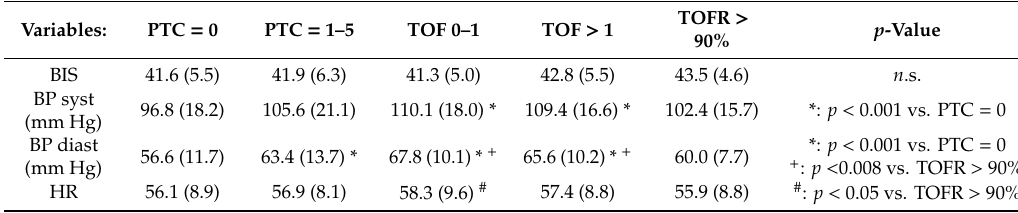
Table 3. Bispectral index and hemodynamic parameters.